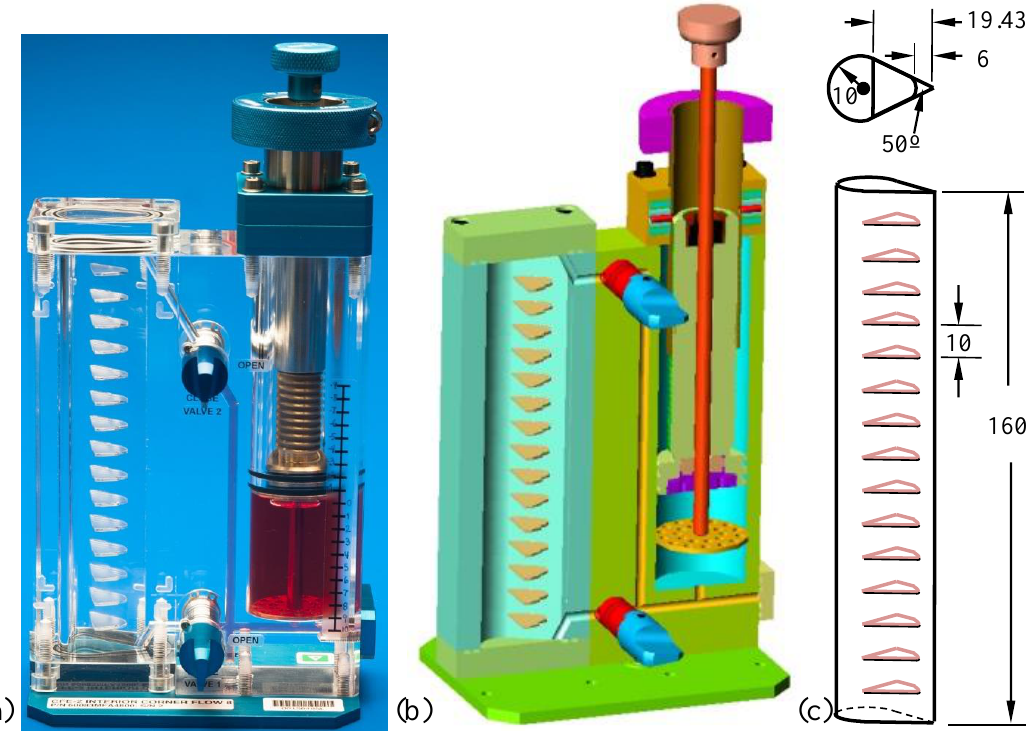
Figure 4. Annotated ICF-8 test Vessel: ( a ) apparatus, ( b ) solid model, and ( c ) wire model with dimensions in